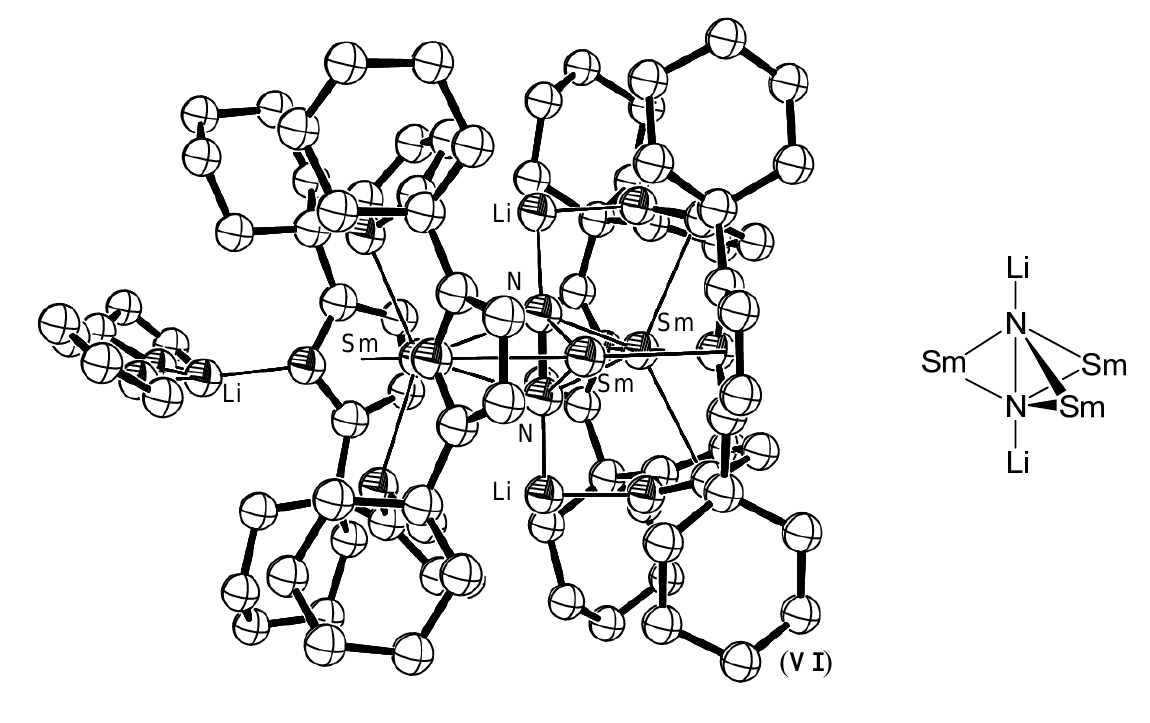
Figure 3. Strongly reduced (N } . THF], ( VI ) [40]. Figure generated from CCDC obtained coordinates. Atoms of {Li(THF) 2 arbitrary size. H atoms are omitted for clarity. Also shown is a partial schematic of the binding observed for (N ) 4- fragment. 2